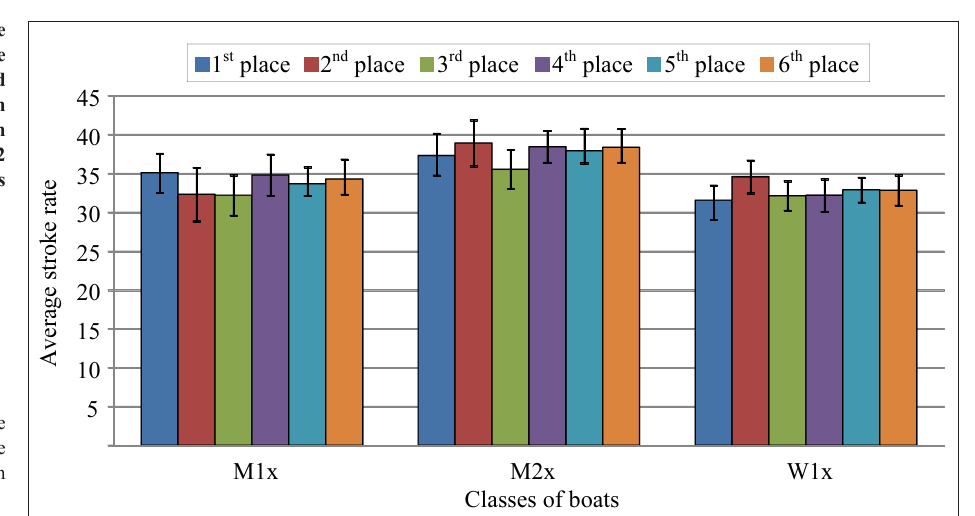
Figure 2. The average Figure 1. Speed changes in the distance of men and women crews in Final A at the pace of men single sculls, double sculls and European Championship 2012 according to places taken women single sculls